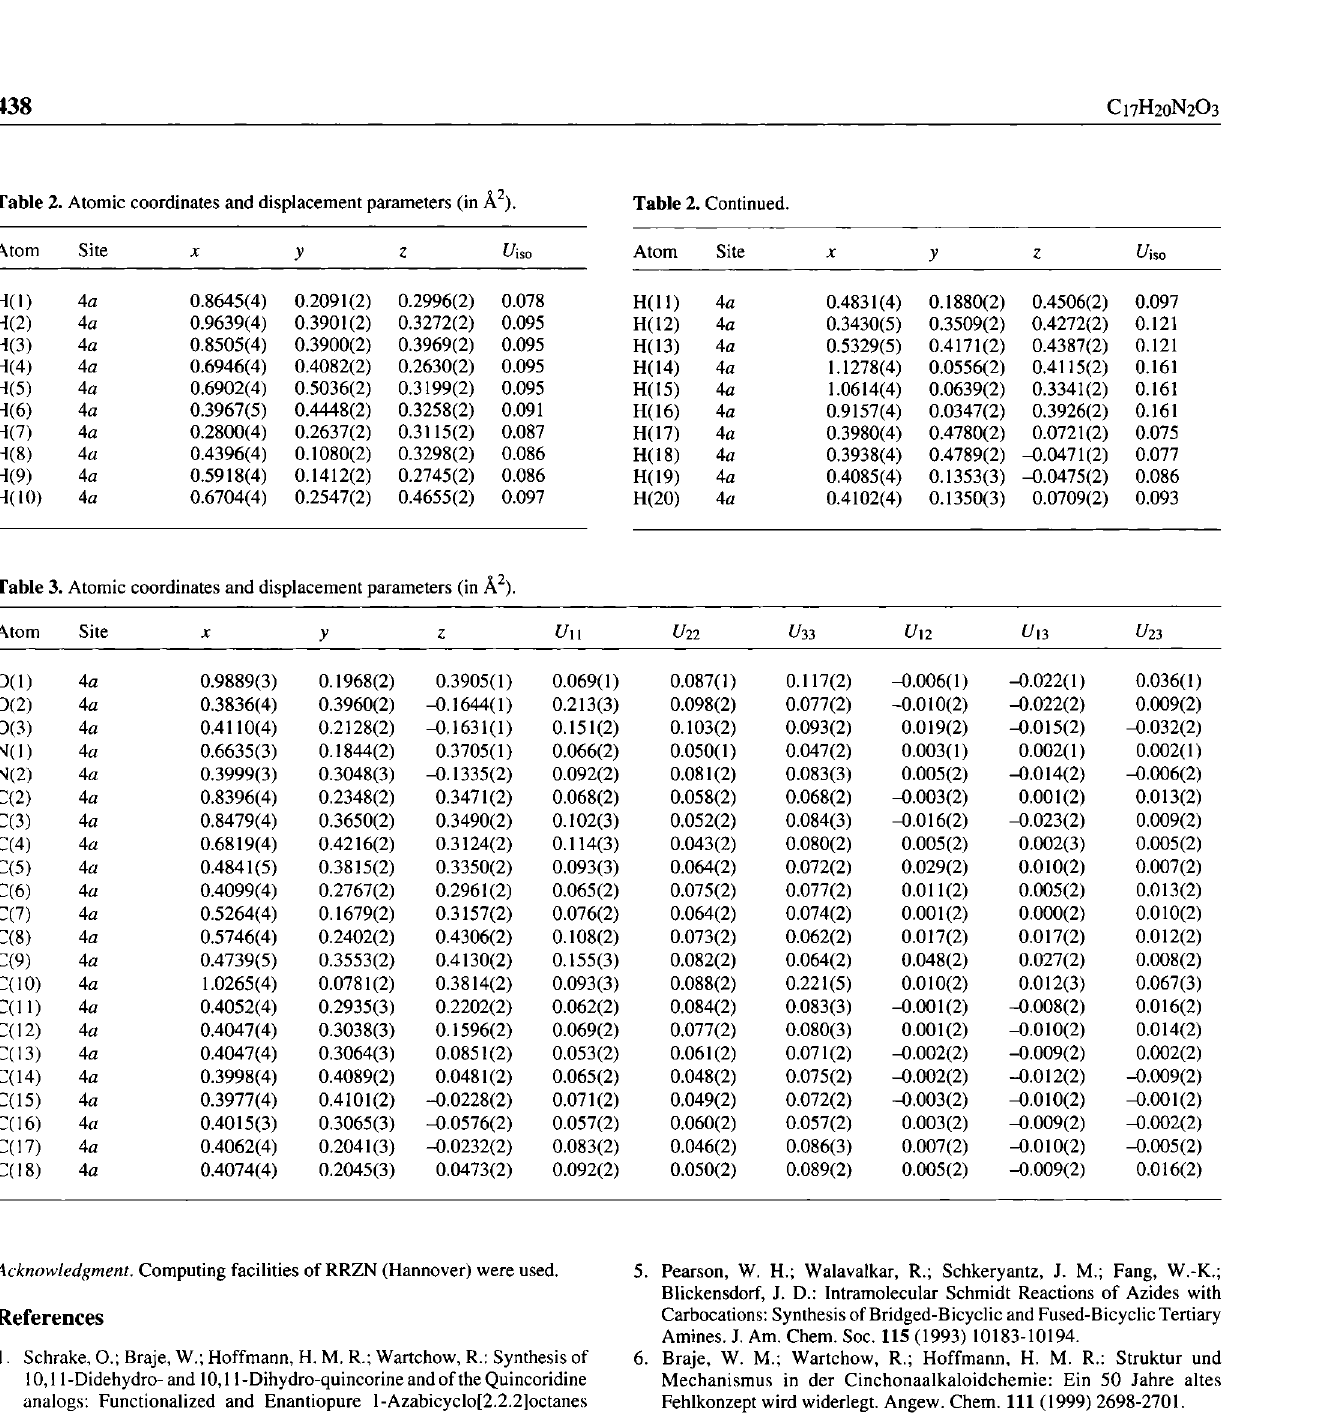
Table 2. Atomic coordinates and displacement parameters (in Ä 2 ). Table 2. Continued.